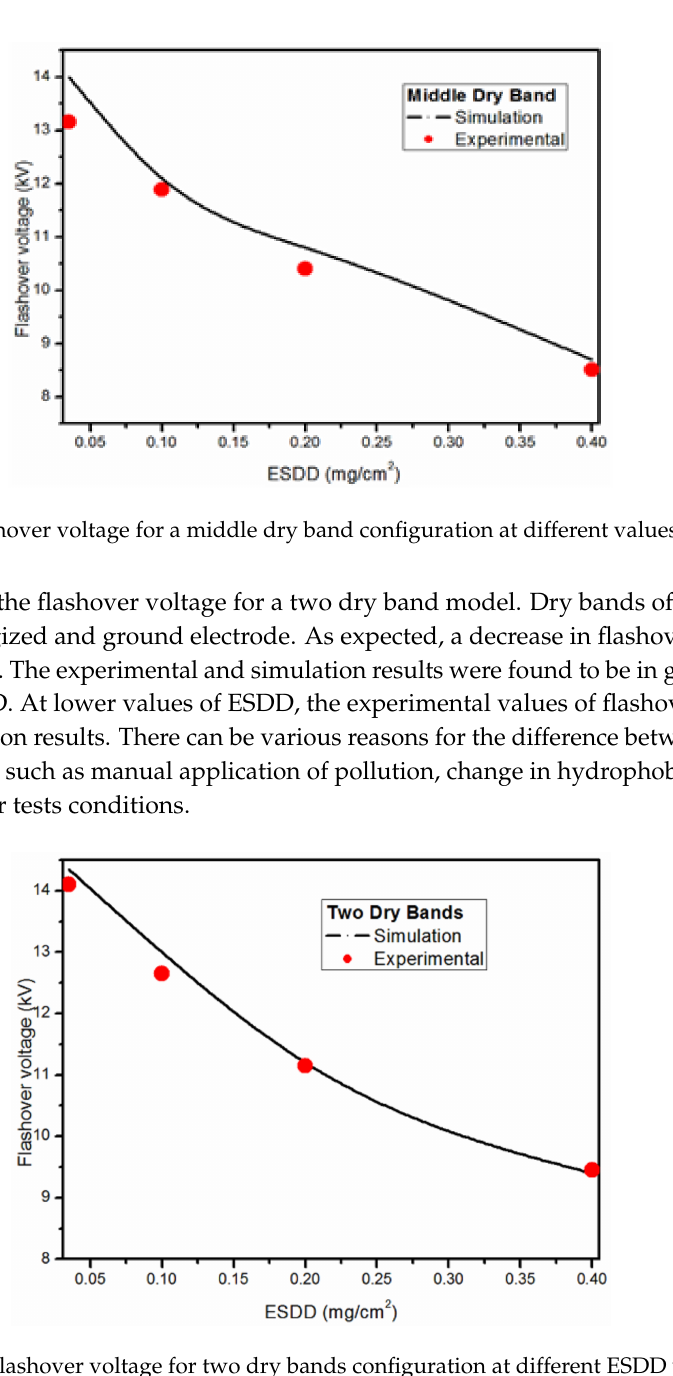
Figure 21. Flashover voltage for two dry bands configuration at different ESDD